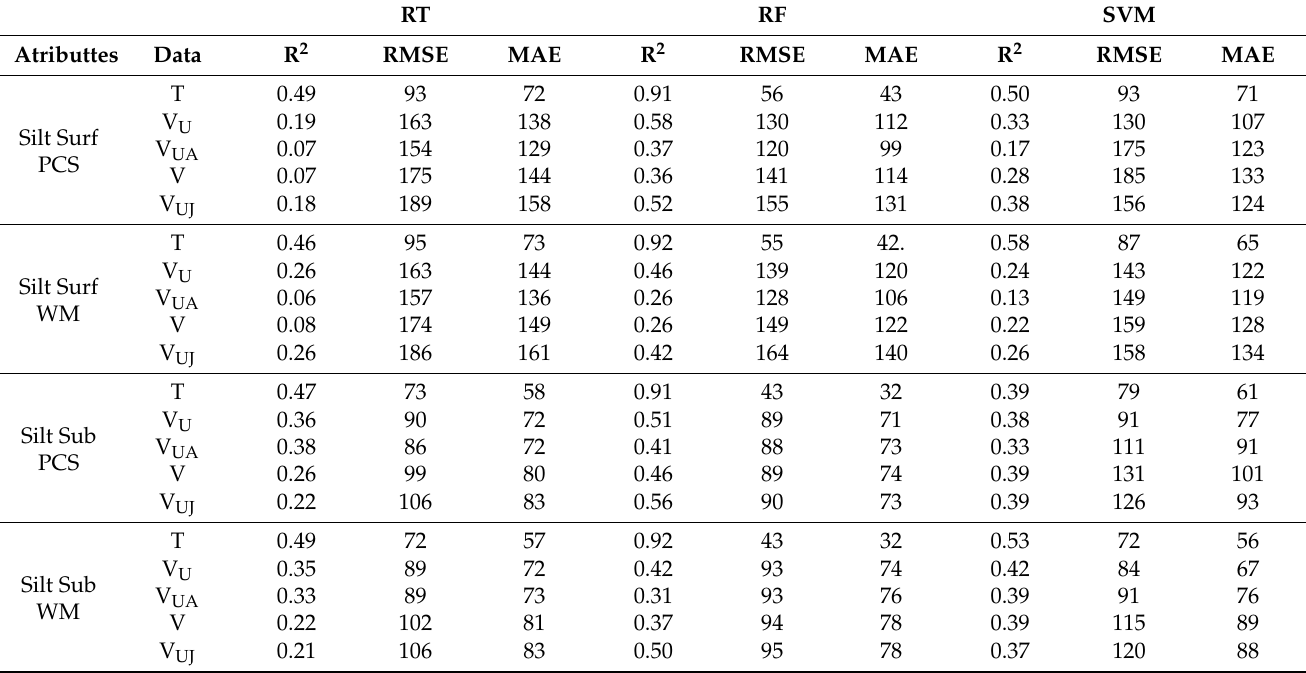
Table 6. Accuracy assessments of soil surface and subsurface silt content predictions using the Reference Area (RA).